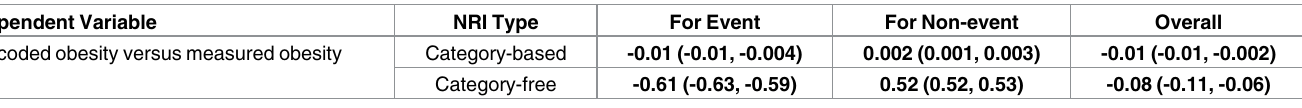
Table 4. Net reclassification indices (NRIs) and 95% confidence intervals (95%CIs)for incident major osteoporotic fracture (MOF) associated with ICD-coded obesity and measuredobesity. Independent